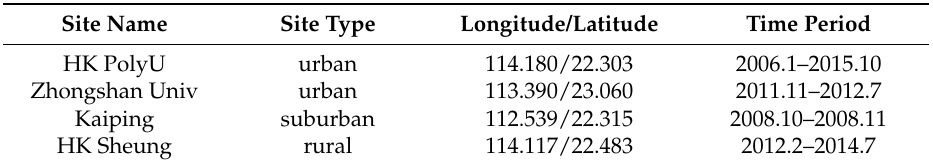
Table 1. AERONET data used in this